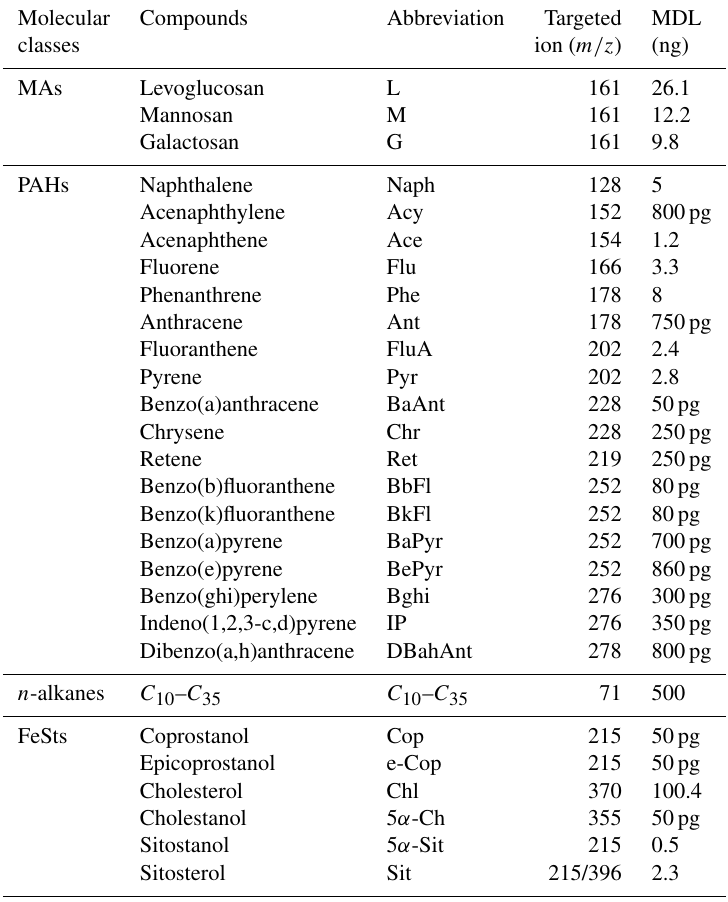
Table 1. Target molecules with their abbreviations, detected mass-to-charge ratio ( m/z ) and method detection limit (ng) calculated as blank values plus three standard deviations or with the signal-to-noise ratio when no analytes were detectable in the